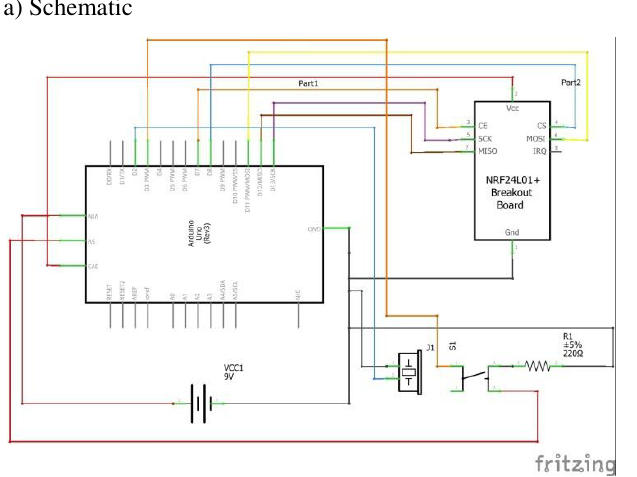
Figure 12. Breadboard implementation of